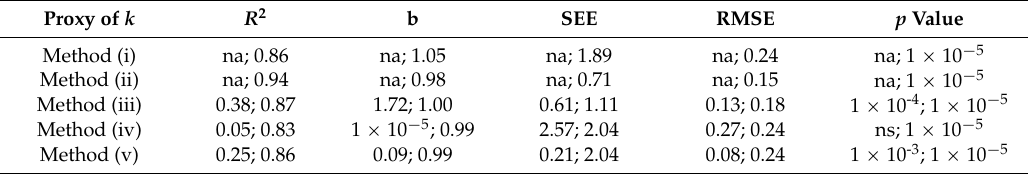
Figure 7. Linear regressions obtained from the comparison between real LAI (LAI r ) and effective LAI using VitiCanopy (LAI-vc e ) with different methods to obtain a proxy of light extinction coefficient ( k ): ( a ) obtaining a real k ( k r ) by inverting Equation (7) (method ii); ( b ) Lowess linear interpolation model based on canopy cover ( f c ) and porosity ( Φ ) (method iii); ( c ) k obtained from a linear regression between k r and large gaps (lg) (method iv) and ( d ) k obtained from the ratio between image luminance (I) and maximum luminance (Io = 12) (method v). Table 4. Statistical results obtained for the k -proxy models (methods iii to v) and from LAI calculation using five different methods: using a common k = 0.7 (method i); obtaining a real k ( k r ) by inverting Equation (7) (method ii); Lowess linear interpolation model based on canopy cover ( f f ) and porosity ( Φ ) (method iii); k obtained from a linear regression between k r and large gaps (lg) (method iv) and k obtained from the ratio between image luminance (I) and maximum luminance (I o = 12) (method v). Not applicable and not statistically significant are denoted by na and ns respectively.